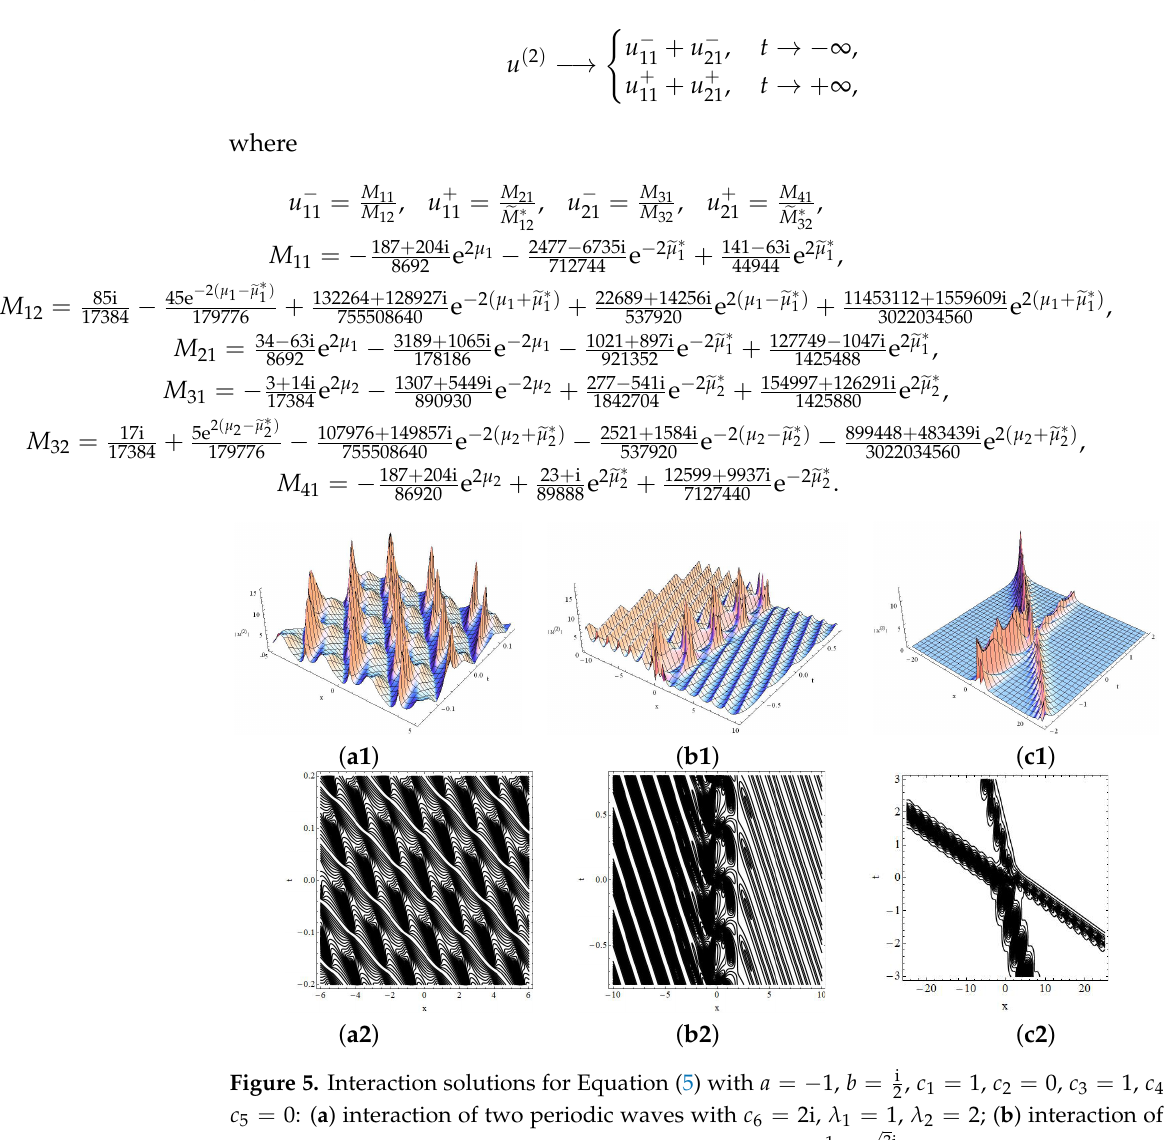
, c 1 = 1, c 2 = 0, c 3 = 1, c 4 = 1, 2 √ 3i + ; ( c ) interaction of breather-like 2 2 + i , λ 2 = 1 3 2 2